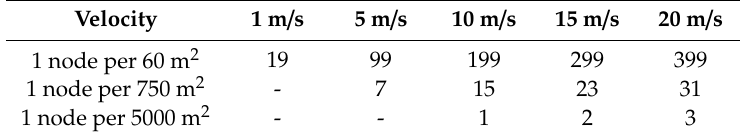
Table 4. Nodes covered in a 20-min flight for di ff erent fv and node